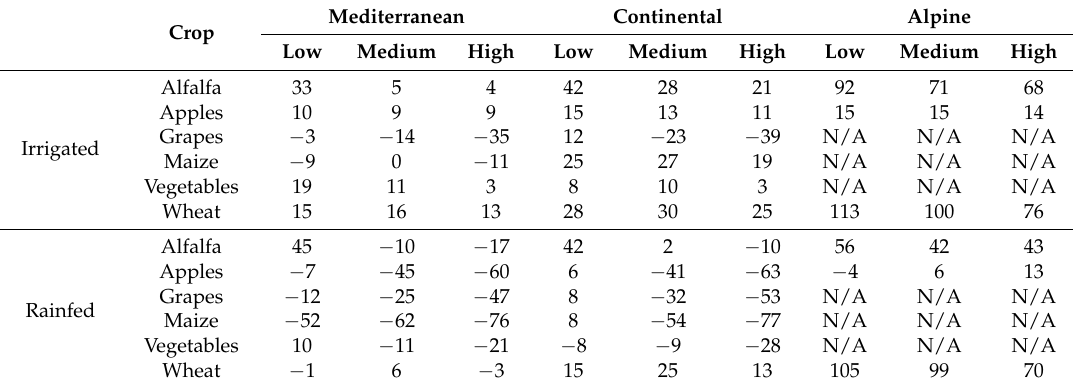
Table 3. Range of crop yield change relative to the current situation (% by 2040s) across the three climate scenarios high, medium and low. Mediterranean Continental Alpine Crop Low Medium High Low